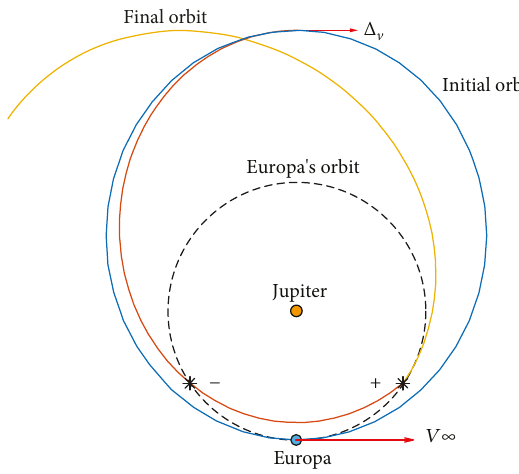
Figure 5: Δ V -EGA